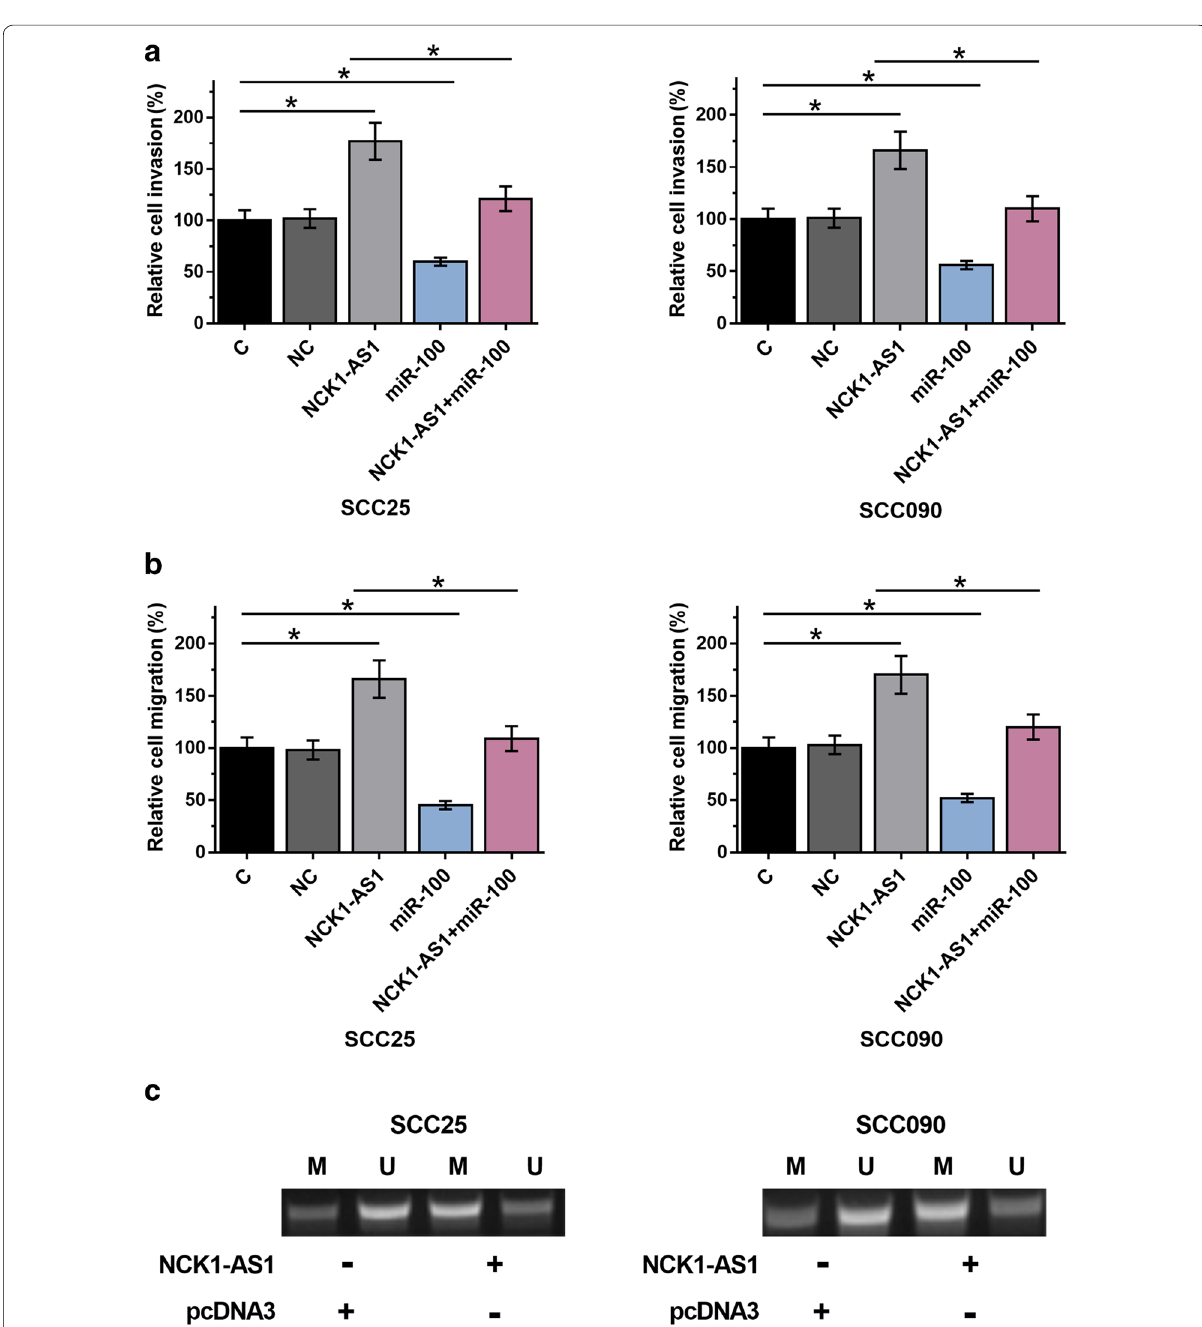
Fig. 5 NCK1-AS1 promoted OSCC cell migration and invasion through miR-100. Transwell invasion and migration data analyzed by one-way ANOVA and Tukey test showed that overexpression of NCK1-AS1 resulted in a significantly increased rate of invasion ( a ) and migration ( b ) in comparison to C and NC groups. Overexpression of miR-100 played an opposite role and attenuated the effects of overexpression of NCK1-AS1 (* p < 0.05). MSP was performed to analyze the effects of overexpression of NCK1-AS1 on the methylation of miR-100 in both SCC25 and SCC090 cells. Experiments were repeated 3 times and representative images were presented ( c